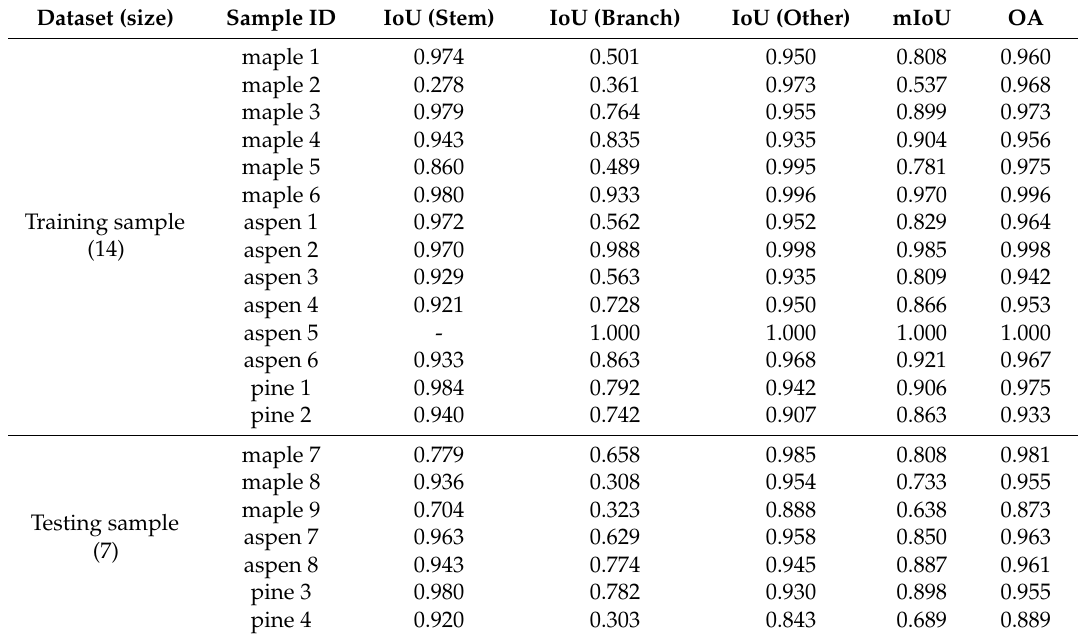
Table 3. 3-D FCN filtering accuracies (IoU, mIoU, and OA) among training and testing samples.